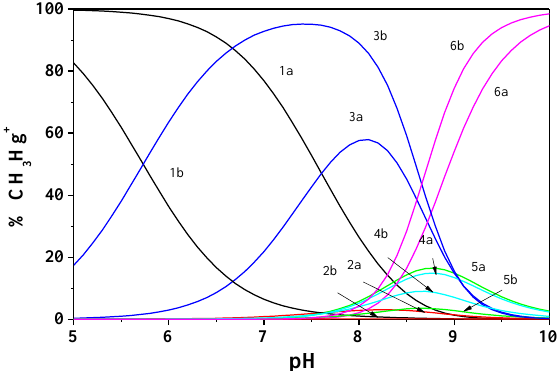
Figure 3. Distribution diagram for the CH 3 Hg + /Dop − species at I = 0.151 mol dm − 3 and different temperatures. Species: 1. MCl; 2. MOH; 3. MLH; 4. ML; 5 MLCl; 6. MLOH. a: T = 298.15 K; b: T = 318.15 K. (Experimental conditions: c CH3Hg+ = 0.5 mmol dm − 3 ; c DOP − = 1.5 mmol dm − 3 ) [M = CH 3 Hg + ; L = Dop − ].